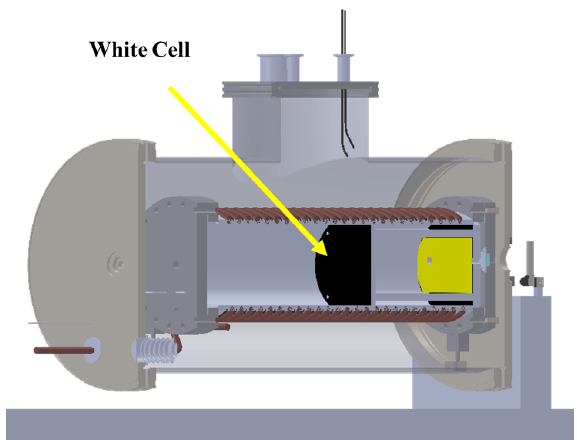
Figure 5. The configuration of the White cell installed inside the sample chamber. The total internal length of the sample cell is about 0.6m, while the White cell occupies about